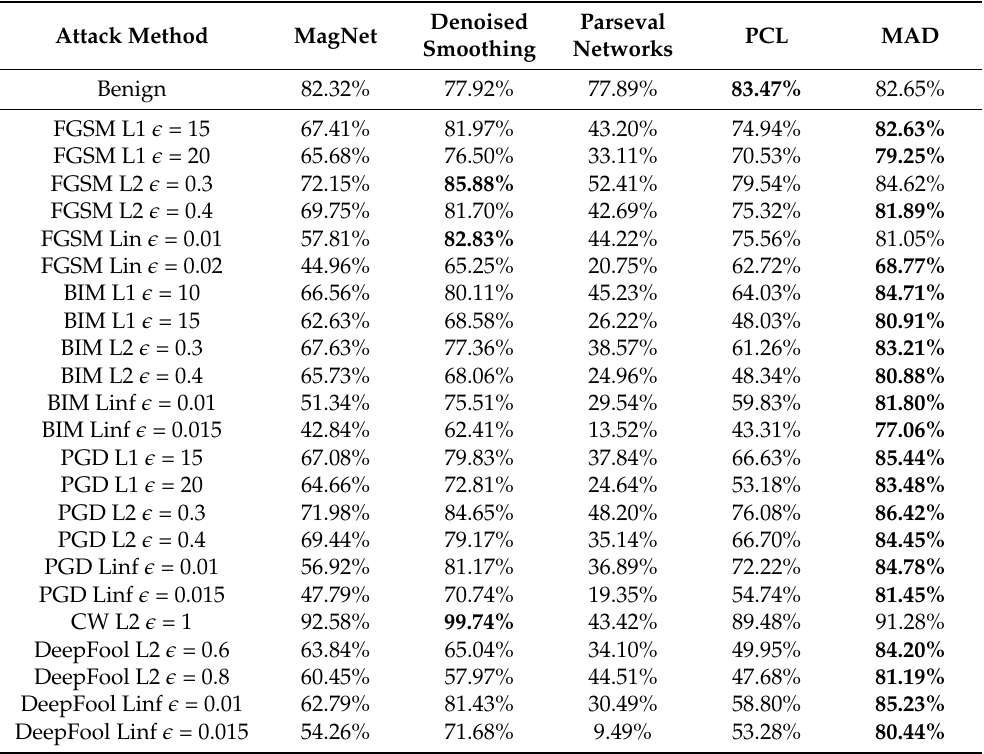
Table 6. Comparison of effects of MAD with different adversarial defense methods on VGG16 with the dataset